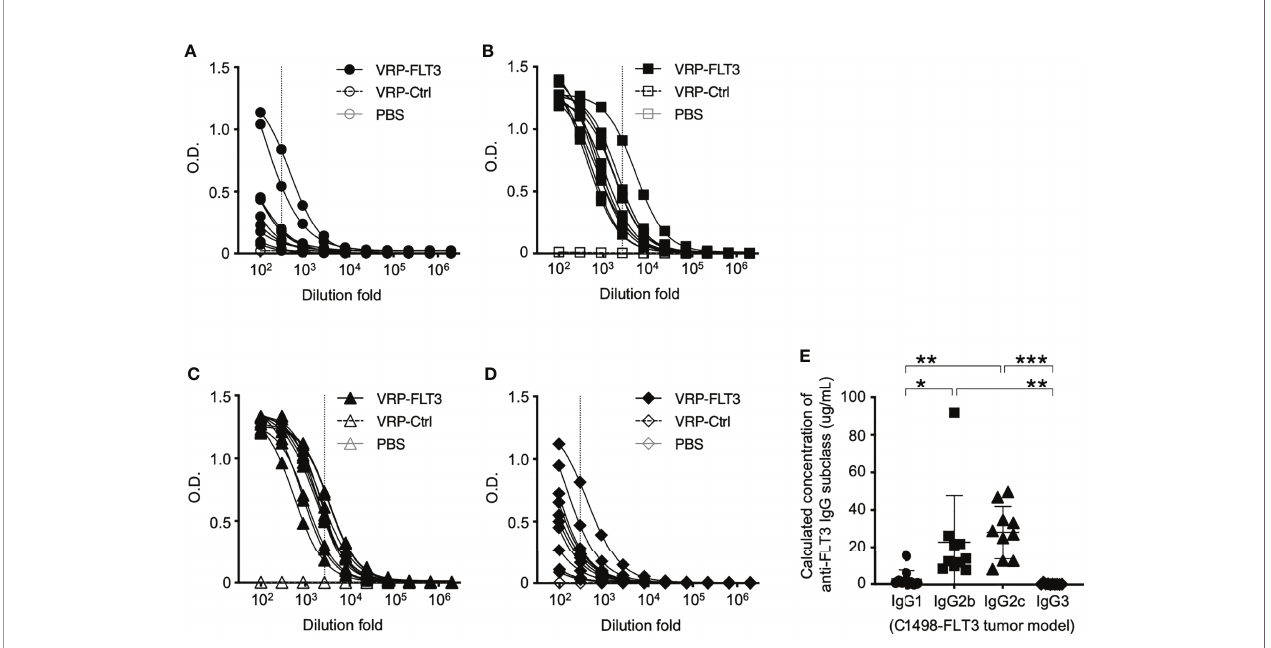
FIGURE 5 | IgG2b and IgG2c are the predominant subclasses of FLT3-speci fi c IgG induced by VRP-FLT3 vaccine. Antigen-speci fi c IgG1 (A) , IgG2b (B) , IgG2c (C) , and IgG3 (D) responses were detected by ELISA using the recombinant FLT3 as the capture antigen. (A – D) Titration curves of samples was shown. One sample in PBS and VRP-Ctrl groups was tested, and ten samples in VRP-FLT3 groups were tested. (E) Levels of anti-FLT3 IgG subclasses were compared by calculating the equivalent IgG subclass concentration using O.D. values at 1:300 dilution of anti-FLT3 IgG1 and IgG3 ELIS as indicated as the vertical dash line in (A) and (D) , and O.D. values at 1:2700 dilution of anti-FLT3 IgG2b and IgG2c indicated as the vertical line in (B, C) ELISAs. Each symbol represents an individual mouse (n=10). Bars represent the mean ± SD. Statistical signi fi cance were determined by one-way ANOVA, *P<0.05, **P<0.01, ***P<0.001. Data represents one of two independent